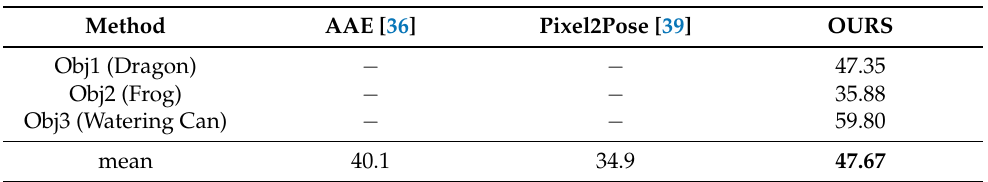
Table 4. Results on the TUD-L dataset using the bop performance score. Higher is better. (The result of AAE and Pixel2Pose are taken from bop website [63] on 31 July 2019).